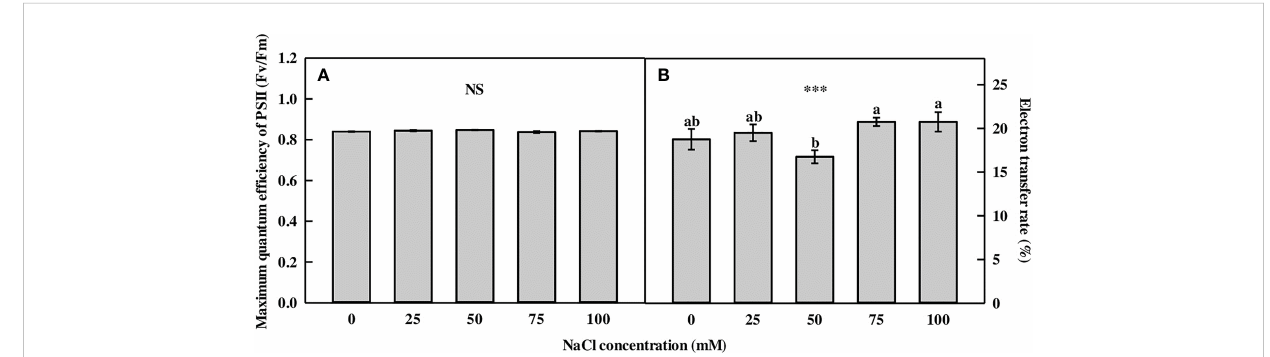
FIGURE 1 The chlorophyll fl uorescence parameters of Limonium tetragonum under different NaCl concentrations ( n = 4). (A) Maximum quantum ef fi ciency of PSII ( F v / F m ) and (B) electron transfer rate. Statistical analysis was performed with Duncan ’ s multiple range test. NS, non-signi fi cant. *** p = 0.001.